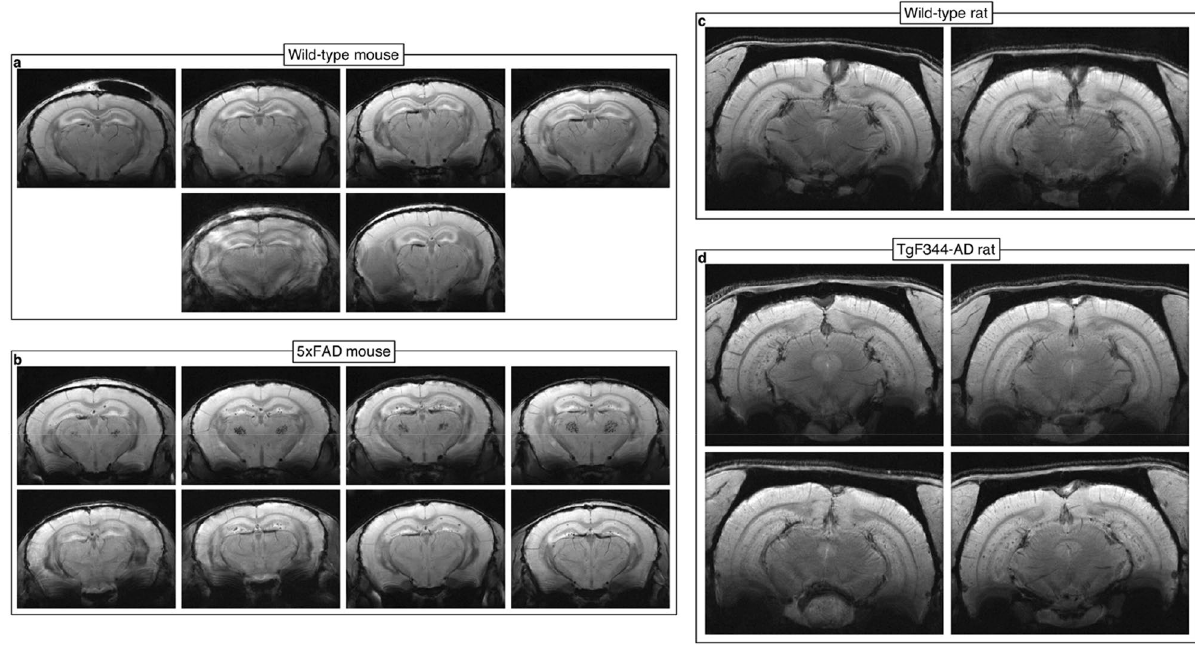
Figure 2. Plaques were MR-visible in all 5xFAD mice and TgF344-AD rats. Single slices from MGE susceptibility-weighted meanTE images of all ( a ) wild-type mice, ( b ) 5xFAD mice, ( c ) wild-type rats, and ( d ) TgF344-AD rats. Compared to the 5xFAD mice, the TgF344-AD plaques had lower contrast and were more obscured by blood vessels. However, the majority of visible plaques in the 5xFAD mice were in the dorsal hippocampus while many more plaques were visible in the TgF344-AD rats, especially in the cortex and ventral